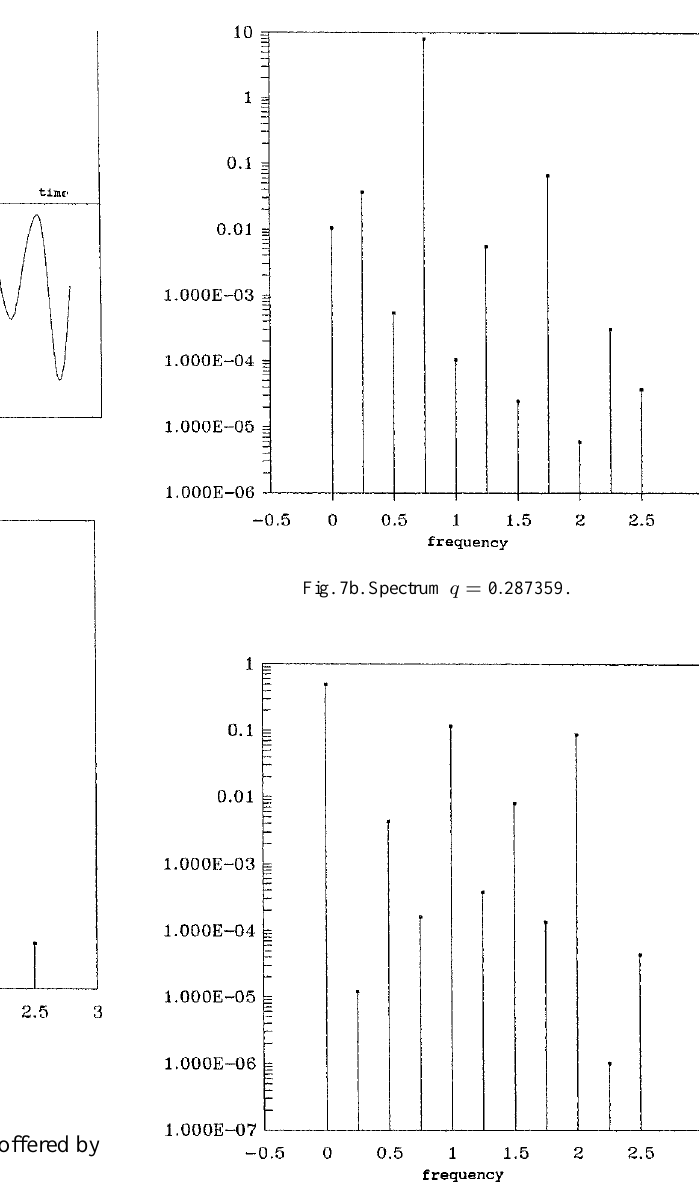
Fig. 7c. Spectrum q = 0 :